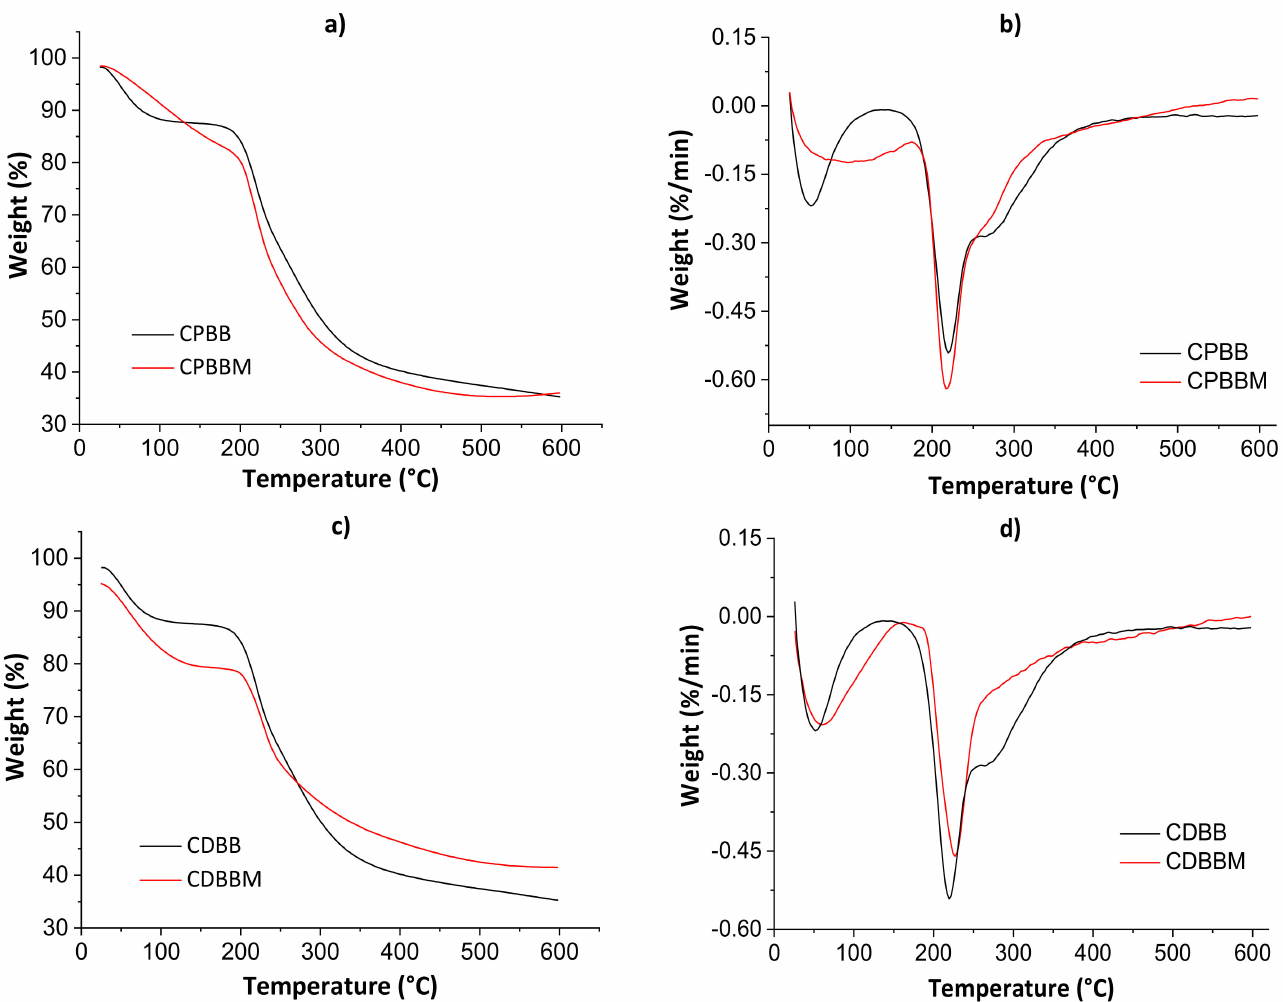
Figure 5. Thermogravimetric curves ( a , c ) and their derivatives ( b , d ) for both blends before and after the MB